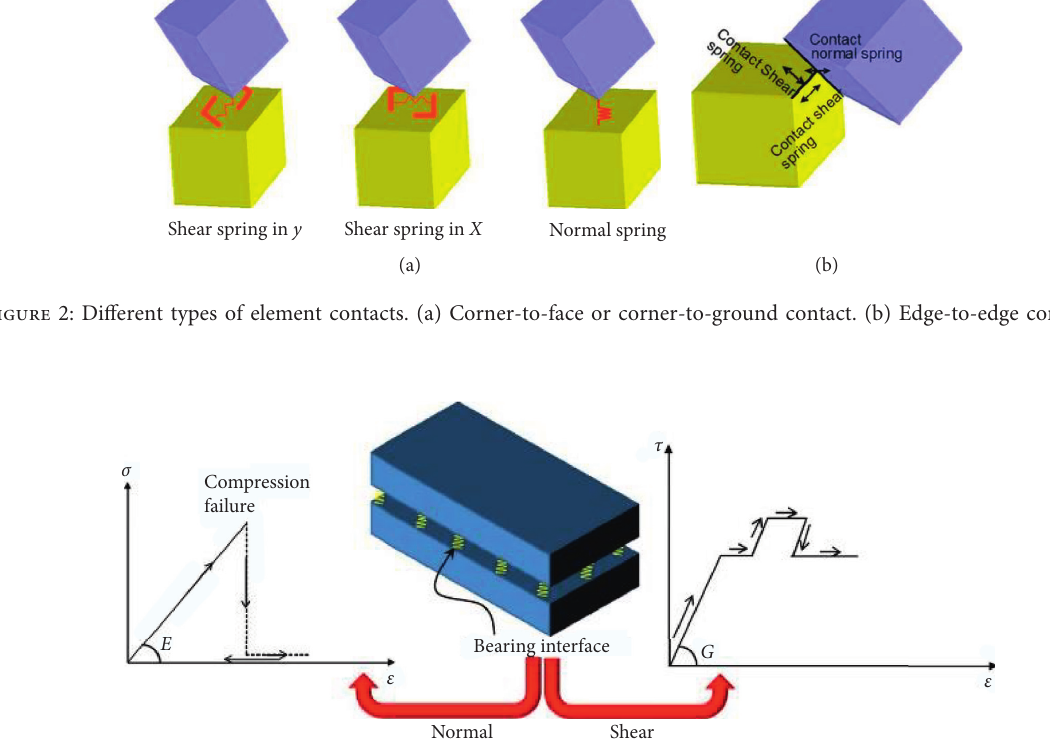
Figure 3: Modeling of a bearing interface with AEM